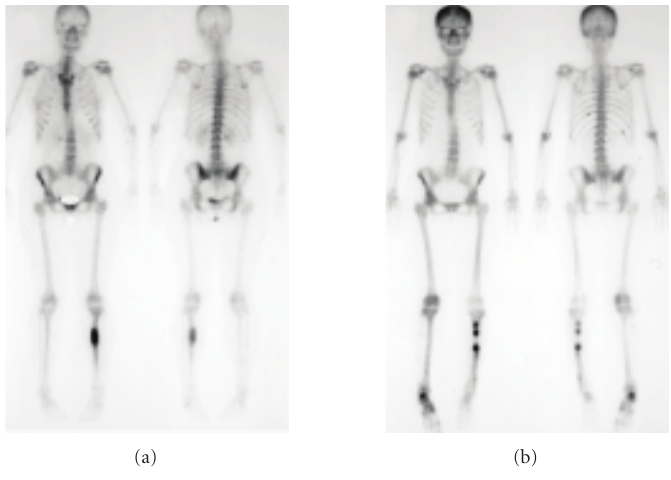
Figure 2: Case 2: isotope bone scans, (a) at diagnosis, demonstrating increased uptake at site of primary tumor in left tibia, (b) after ifosfamide therapy and surgery, demonstrating continued increased uptake at site of primary tumor and new abnormality in region of right